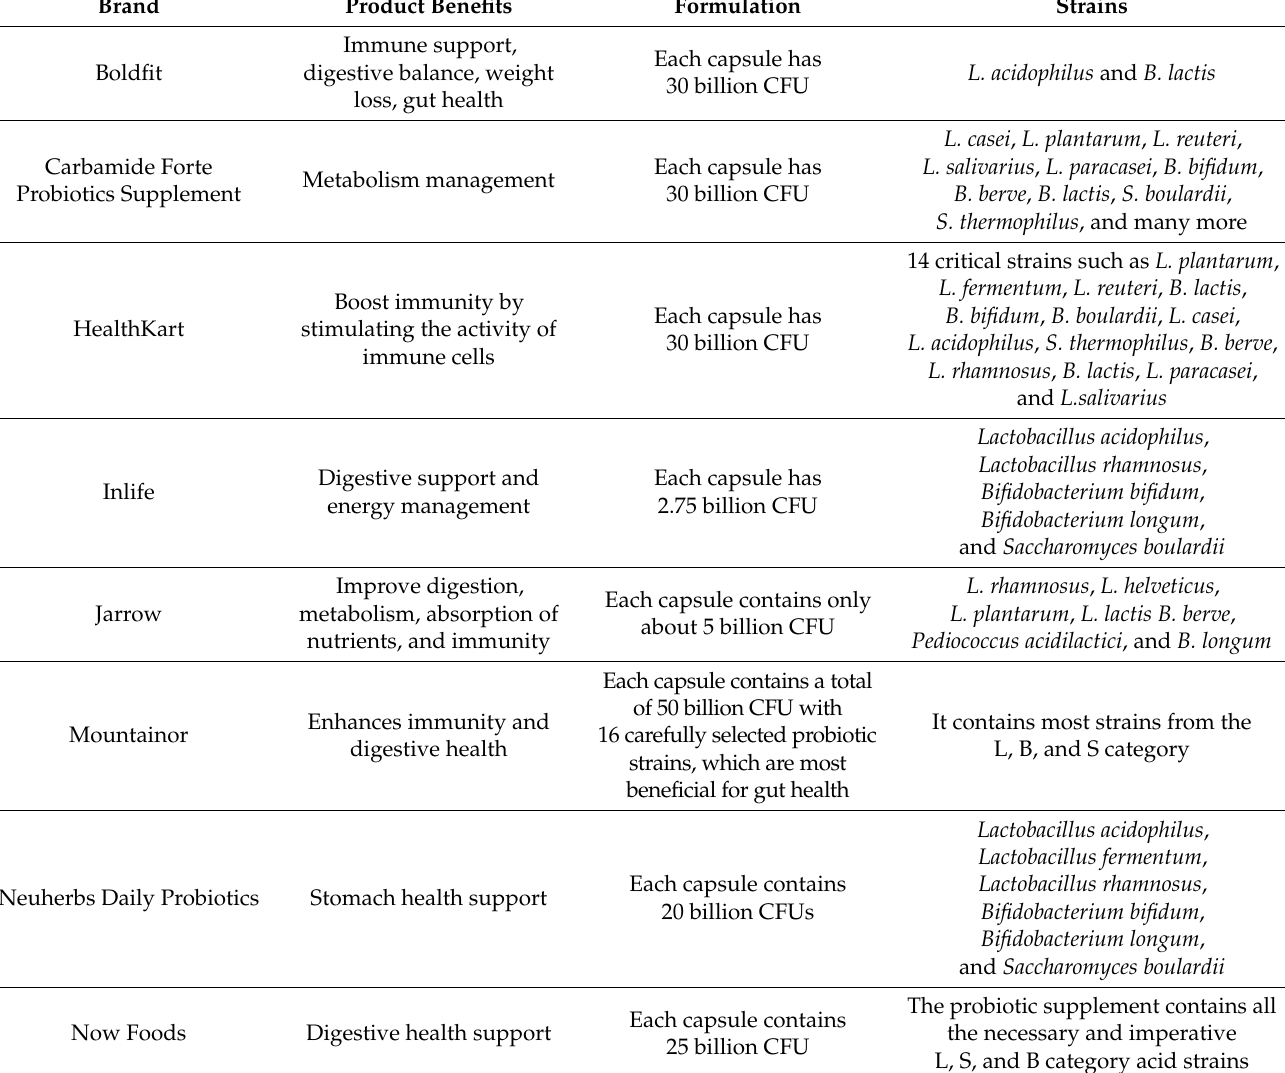
Table 1. Different described probiotics available on the